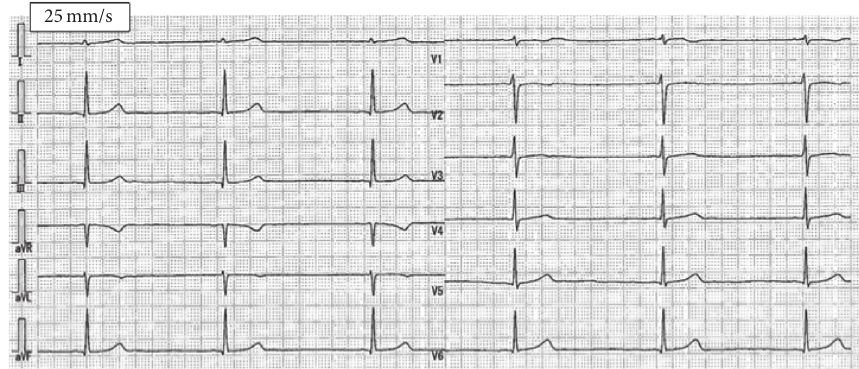
Figure 1: 12-lead electrocardiogram shows bradycardia (heart rate 35 beats/min) with junctional rhythm; QT interval 520 ms (QTc interval 397 ms).